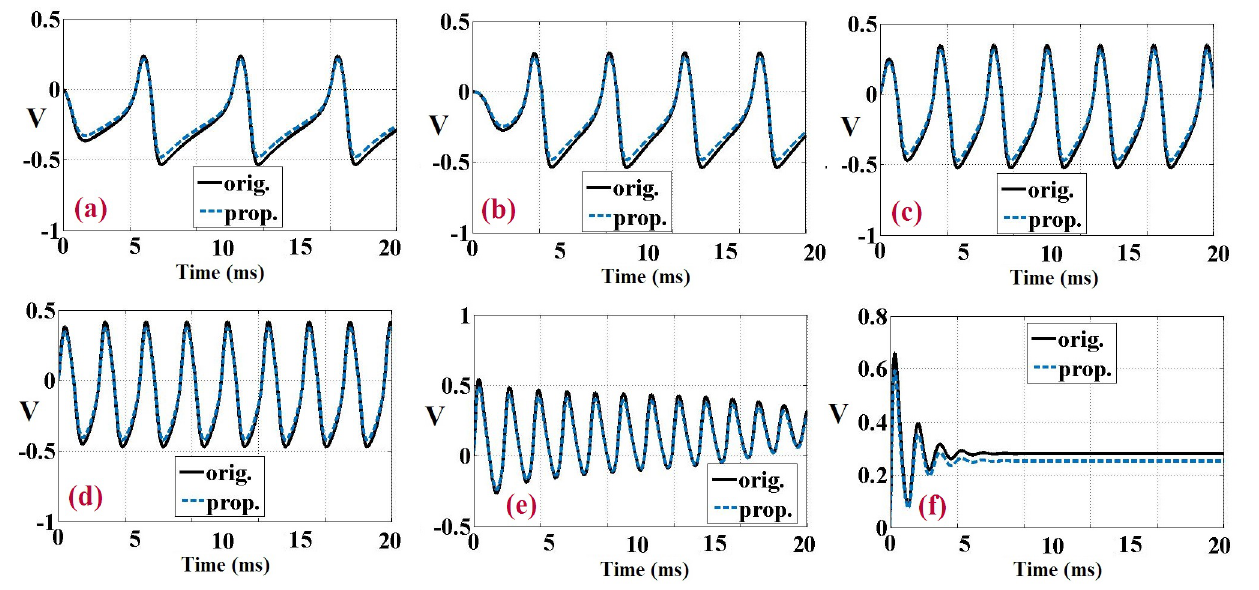
Figure 4. Comparison between spiking patterns of two models (original and proposed). ( a – f ): Spiking patterns for considering the stimulus currents as: I Stimulus = 0.1 , I Stimulus = 0.2 , I Stimulus = 0.5 , I Stimulus = 1 , I Stimulus = 2 , and I Stimulus = 3 .